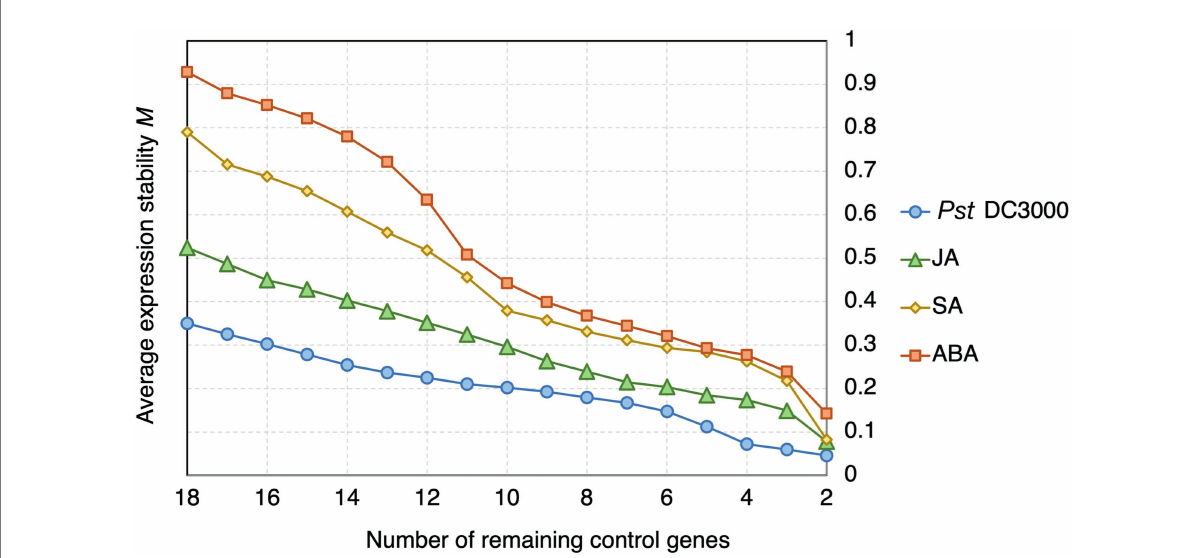
FIGURE 6 geNorm analysis of the average expression stability values of the candidate reference genes under Pst DC3000, JA, SA, and ABA treatments. Average expression stability values ( M ) of the remaining control genes were calculated by a stepwise exclusion of the least stable control gene among the reference gene candidates under each treatment using geNorm. The higher the M value, the lower is the ranking of the reference gene candidate in terms of expression stability.